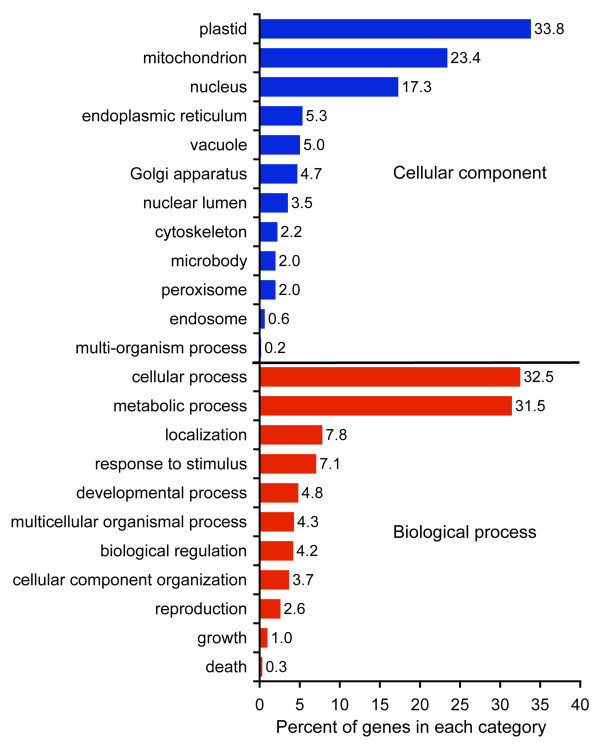
Distribution of genes in the transcriptome assembly assigned to broad GO categories. Cellular components (blue) and biological processes (red). Percentages indicate the proportion of sequences assigned within each subcategory using the program BLAST2GO, which assigns putative function to each transcript based on similarity to proteins with GO annotations from other organisms.